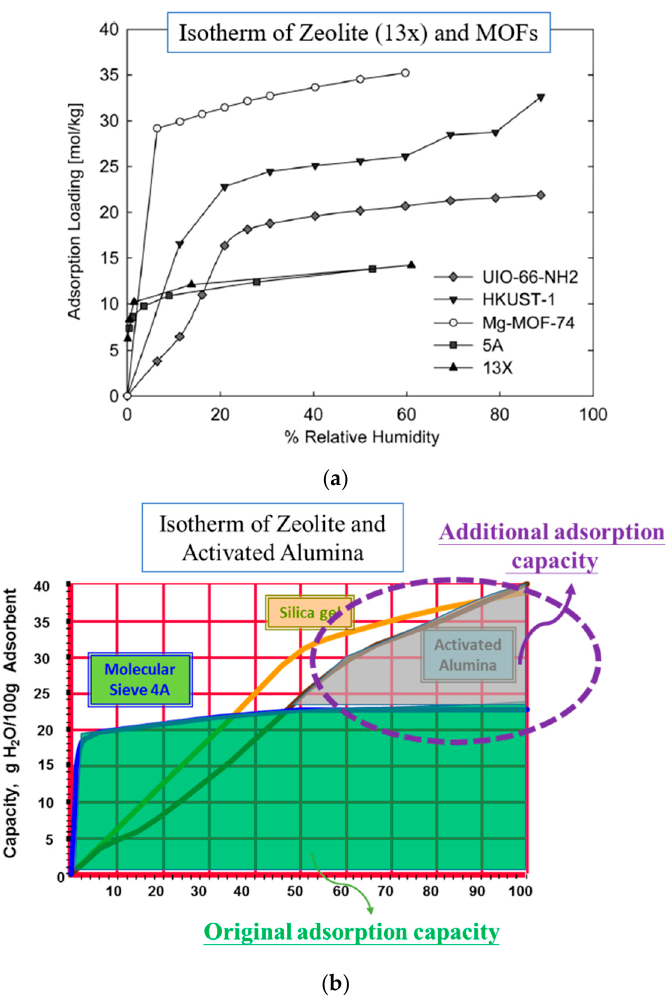
Figure 3. ( a ) Isotherm adsorption curve of different desiccants, and ( b ) Adsorption capacity of the composite desiccant construction system.